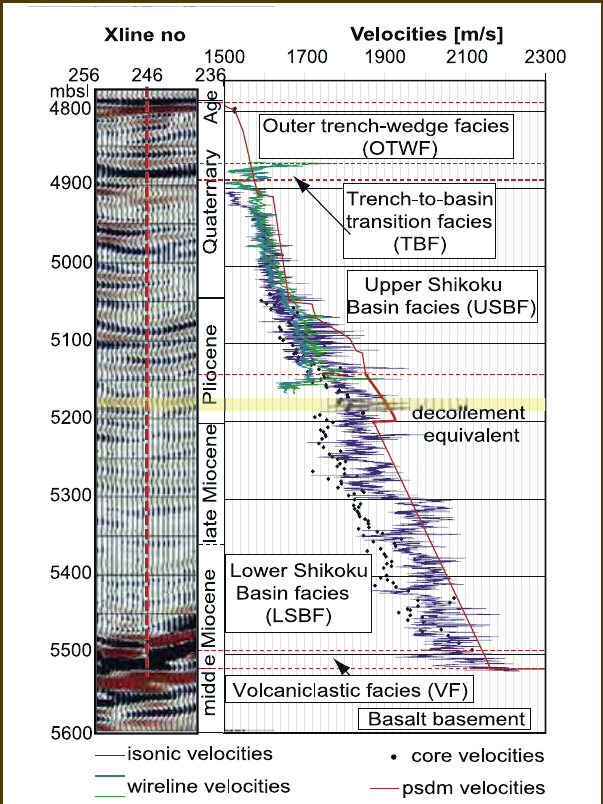
Figure 2. Prestack Depth Migration PSDM depth section across ODP Site 1173 (left); comparison of velocities obtained from PSDM with velocities from cores and logs at Site 1173 (right, from Pisani et al.,